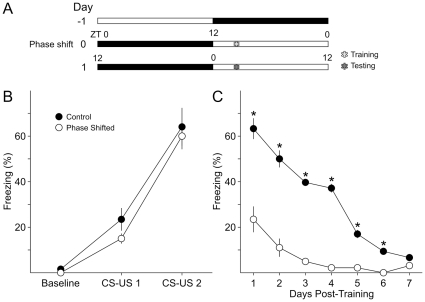
Phase shift prior to training reduced recall, but not acquisition, of contextual fear-conditioned behavior.
A) Schematic illustration of the experimental design. In this and all subsequent experiments, adult male mice were entrained to a 12∶12 LD cycle for at least 2 weeks. One group (n = 6) was subjected to a 12 hr extension of the dark phase on Day -1 to cause a phase inversion by Day 0. On Day 0, both the phase shifted and the control group (n = 8) were trained at ZT 3. 24 hr after training, both groups of mice were returned to the same context for testing of the recall in once a day. B) Acquisition of the conditioned fear behavior was not altered by the phase shift. Freezing in response to CS-US 1 and CS-US 2 was not different between the control and phase shifted groups. C) Recall of the conditioned fear was dramatically reduced by the phase shift. The phase shifted group displayed significantly reduced freezing compared to the control group upon testing. In this and subsequent experiments, two way repeated measures analysis of variance (2RM ANOVA) followed by Bonferroni's pairwise multiple comparison t-tests were used to assess differences between the cohorts. The criterion level for significance was set at P<0.05, and the “*” symbol indicates significant differences between control and phase-shifted groups. Error bars represent standard error mean (S.E.M.).